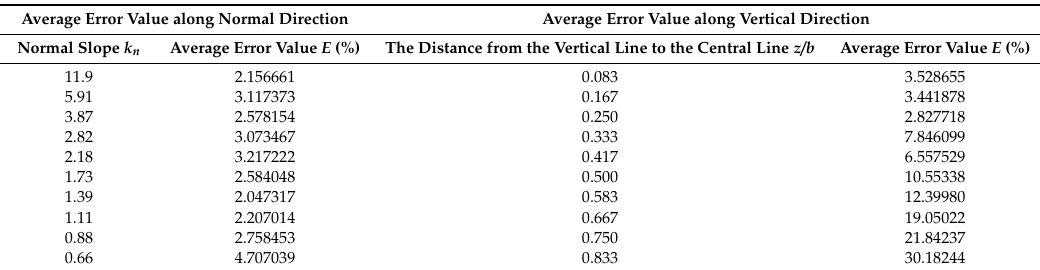
Table 2. Accuracy comparison of velocity distribution along the vertical wall and normal directions with S2: h = 0.1200.